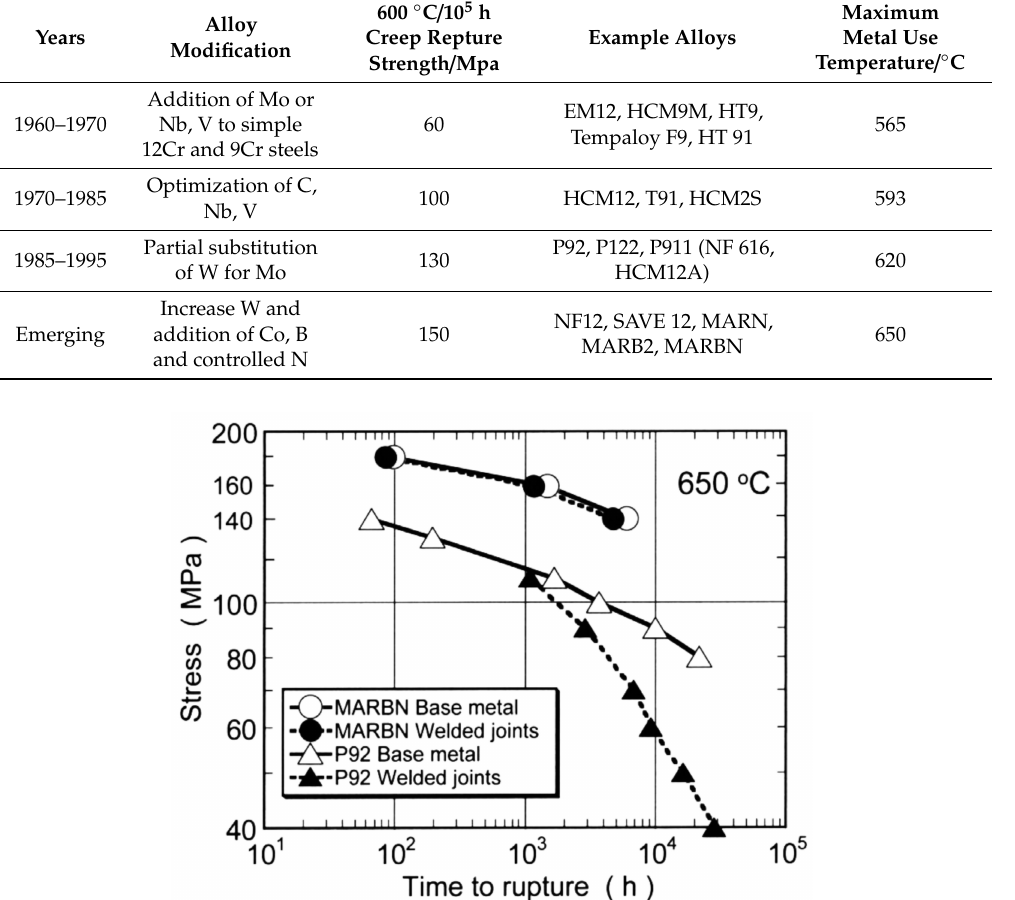
Table 1. Development of 9–12%Cr martensitic steels [34,35].